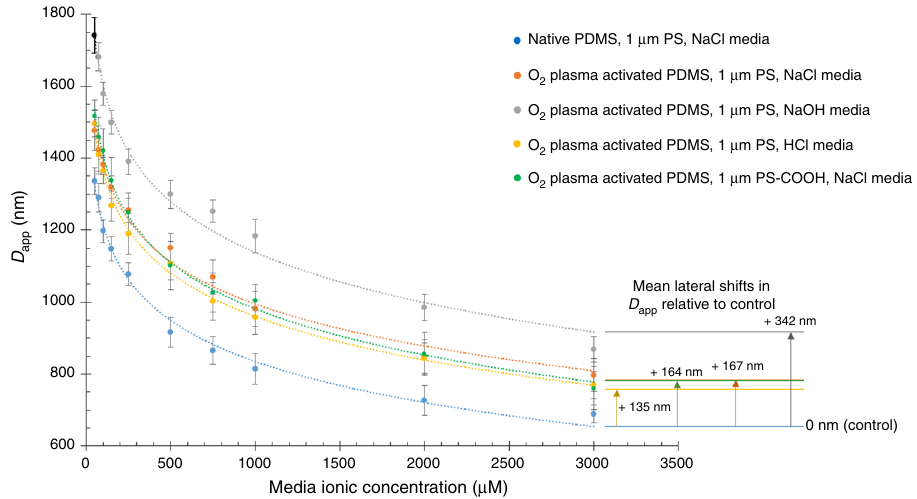
Relative lateral D app shifts for different device surface, media and bead surface